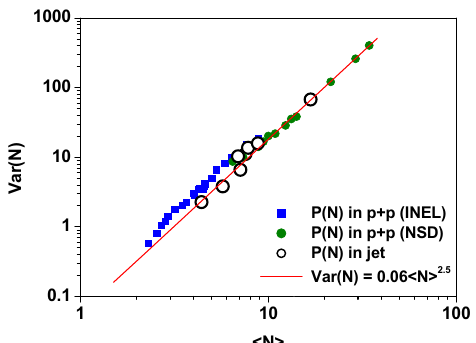
Figure 1. Variance of charged particles multiplicity distribution as a function of average charged multiplicity. By squares and circles we indicate data on particle production in proton + proton collisions: squares (inelastic data) are from the compilation for beam energy 3.7-303 GeV presented in [10], full circles (non-single di ff ractive data) are from the compilation [11]. Open circles are from data on particle production in jets [12–14]. A line shows our fit to the